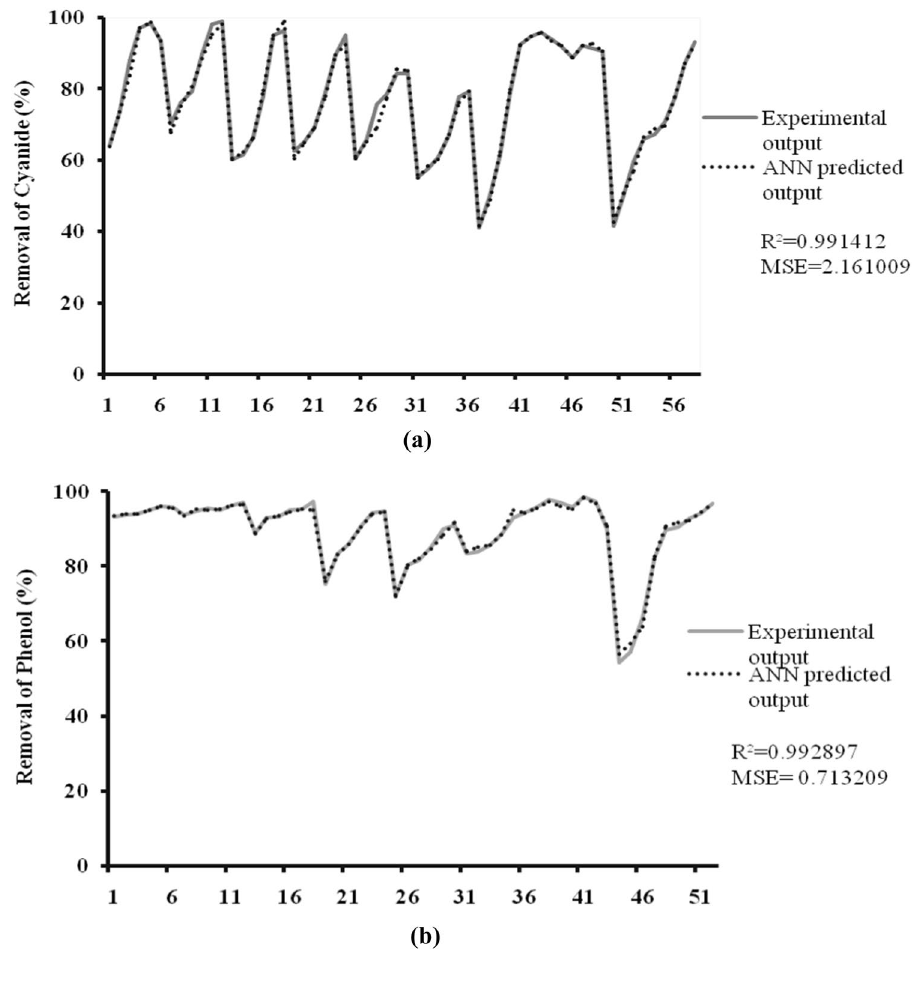
Fig. 9 a Experimental vs ANN-predicted output removal of cyanide. b Experimental vs ANN-predicted output removal of phenol